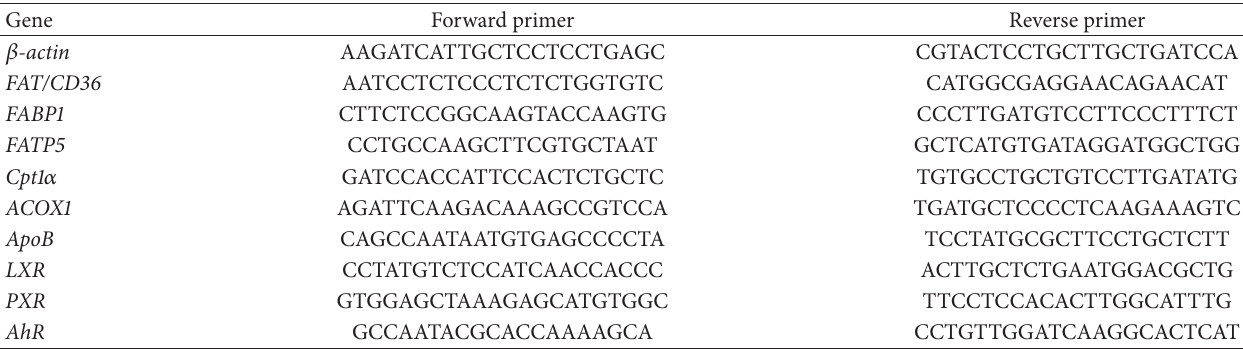
Table 1: Primers for real-time PCR